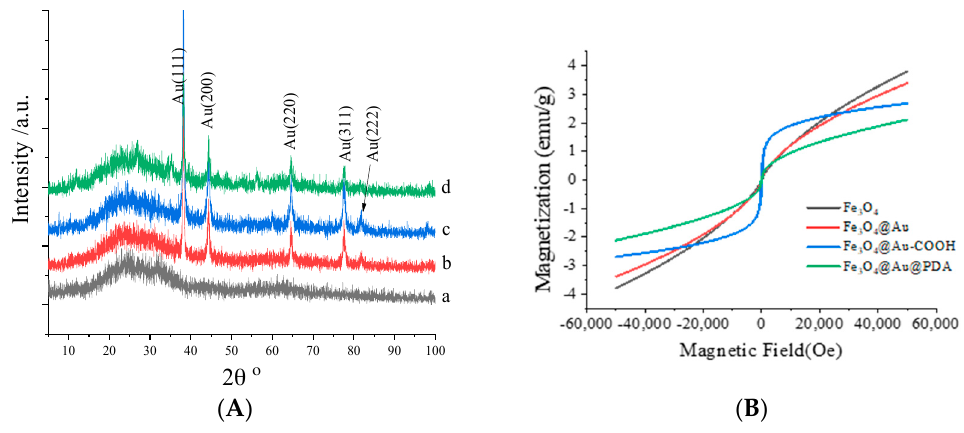
Figure 4. XRD spectra ( A ) and magnetization hysteresis loops ( B ) of the magnetic nanomaterials. Fe 3 O 4 NPs (a), Fe 3 O 4 @Au NPs (b), Fe 3 O 4 @Au-COOH NPs (c), Fe 3 O 4 @Au@PDA MNPs (d).